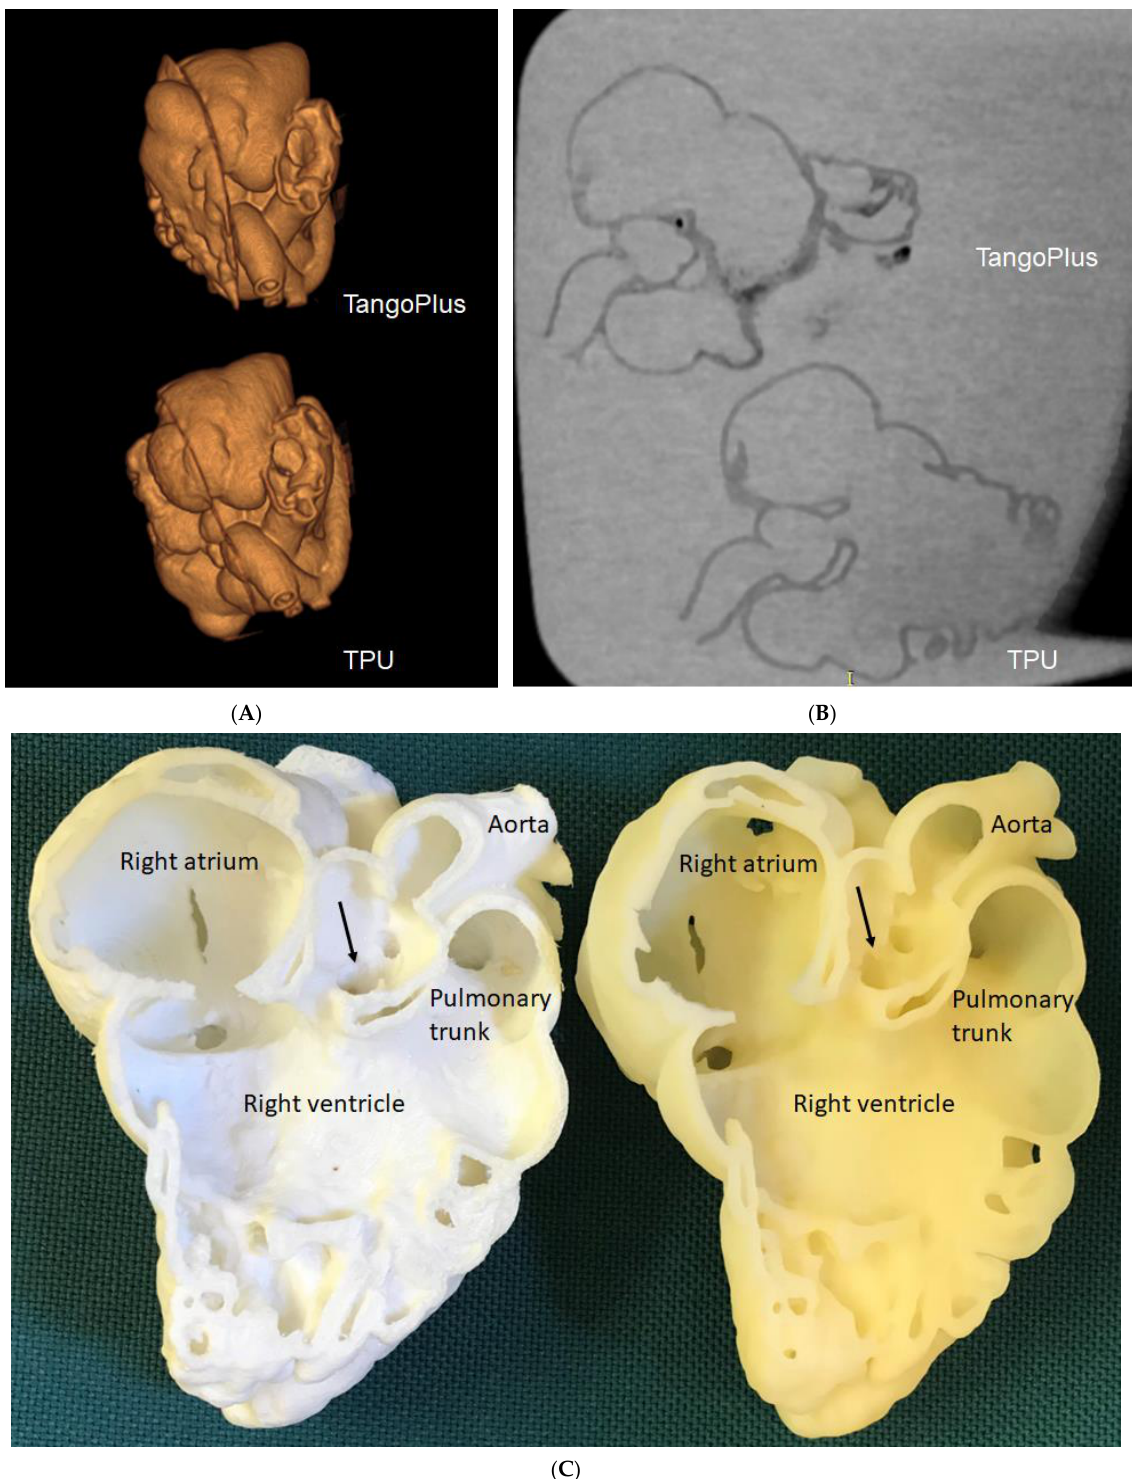
Figure 5. Three-dimensional-printed CHD models with the use of different materials for comparison of model accuracy. ( A ): Three-dimensional CT volume rendering of the 3D-printed models showing similar anatomical details. ( B ): Two-dimensional axial CT views of the 3D printed models. ( C ): Inside view of cardiac chambers and aortic structures on both models. The white model is printed with TPU, while the yellow model is printed with TangoPlus. Arrows refer to the subaortic ventricular septal